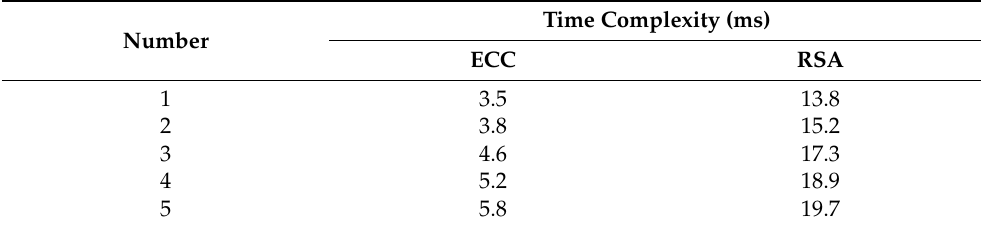
Table 6. Time complexity comparison of ECC and